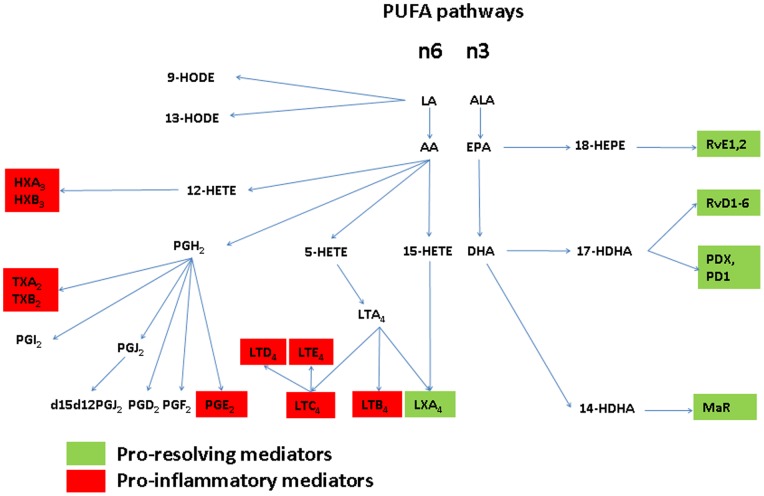
PUFA-metabolites and lipid mediators originating from the n6- and n3-polyunsaturated fatty acids (PUFAs).In addition, bioactive pro-resolving as well as pro-inflammatory eicosanoids and docosanoids were marked in red or green, respectively. Abbreviations: AA: arachidonic acid; ALA: alpha-linolenic; DHA: docosahexaenoic acid, EPA: eicosapentaenoic acid; HEPE: hydroxyeicosapentaenoic acid; HETE: hydroxyeicosatetraenoic acid; HDHA: hydroxydocosahexaenoic acid¸ LA: linoleic acid; LT: leukotriene; LX: lipoxin, HODE: hydroxyoctadecadienoic acid; HX: hepoxilin; MaR: maresin; PD: protectin; PG: prostaglandin; Rv: resolvin; TX: thromboxane.